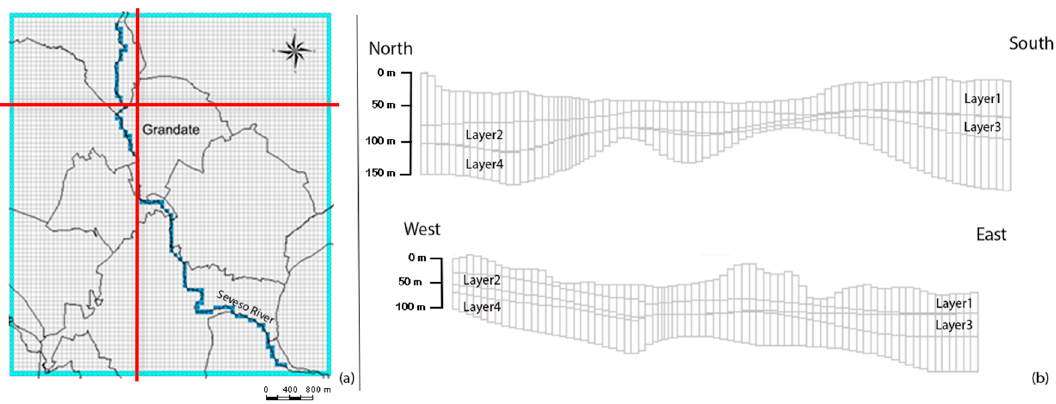
Figure 7. Horizontal ( a ) and vertical ( b ) discretization (in the plant, red lines indicate the sections traces, the River condition is blue, while light blue represents GHB conditions contouring the model).